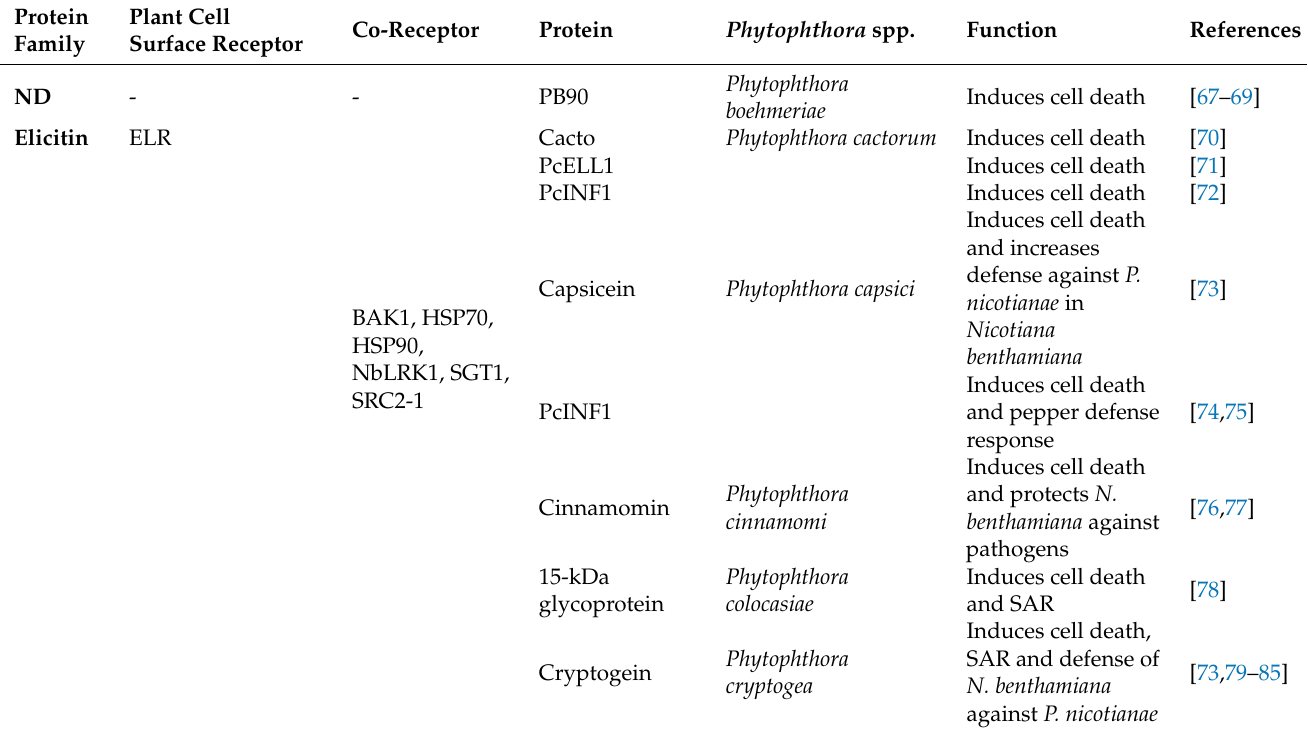
Table 1. Apoplastic cell-death-inducing proteins identified in Phytophthora